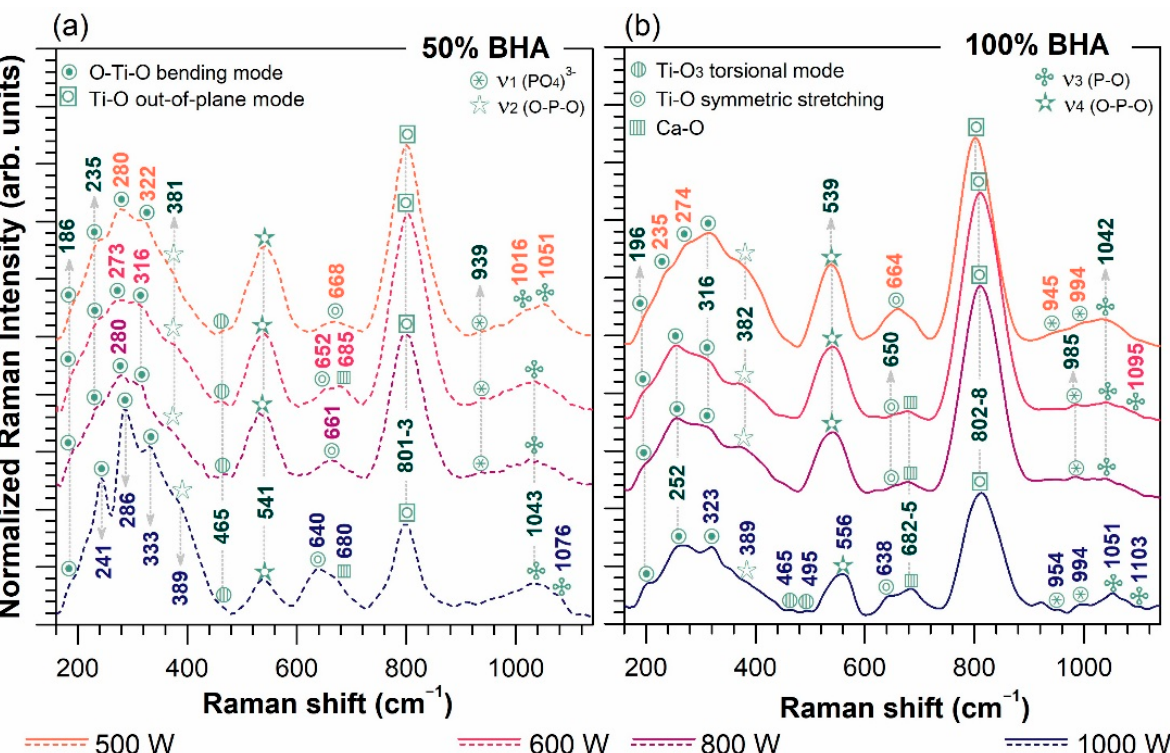
Figure 3. Raman spectra collected for the laser-cladded samples deposited using BHA powder contents of ( a ) 50 and ( b ) 100 wt.% at the four beam powers.